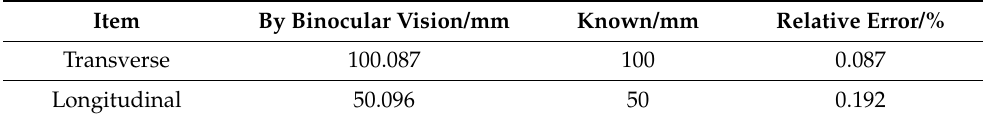
Table 2. Accuracy of binocular vision